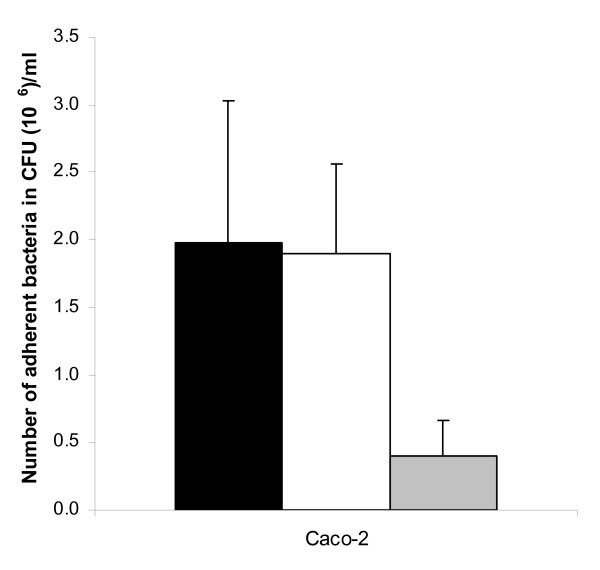
Adherence to Caco-2 cells. Adherence of E135 (grey bars), E1162 (black bars) and E1162Δesp (white bars) to differentiated Caco-2 cells (14 days old). Adherence levels are expressed as the mean number of CFU per ml ± the standard deviation (SD).